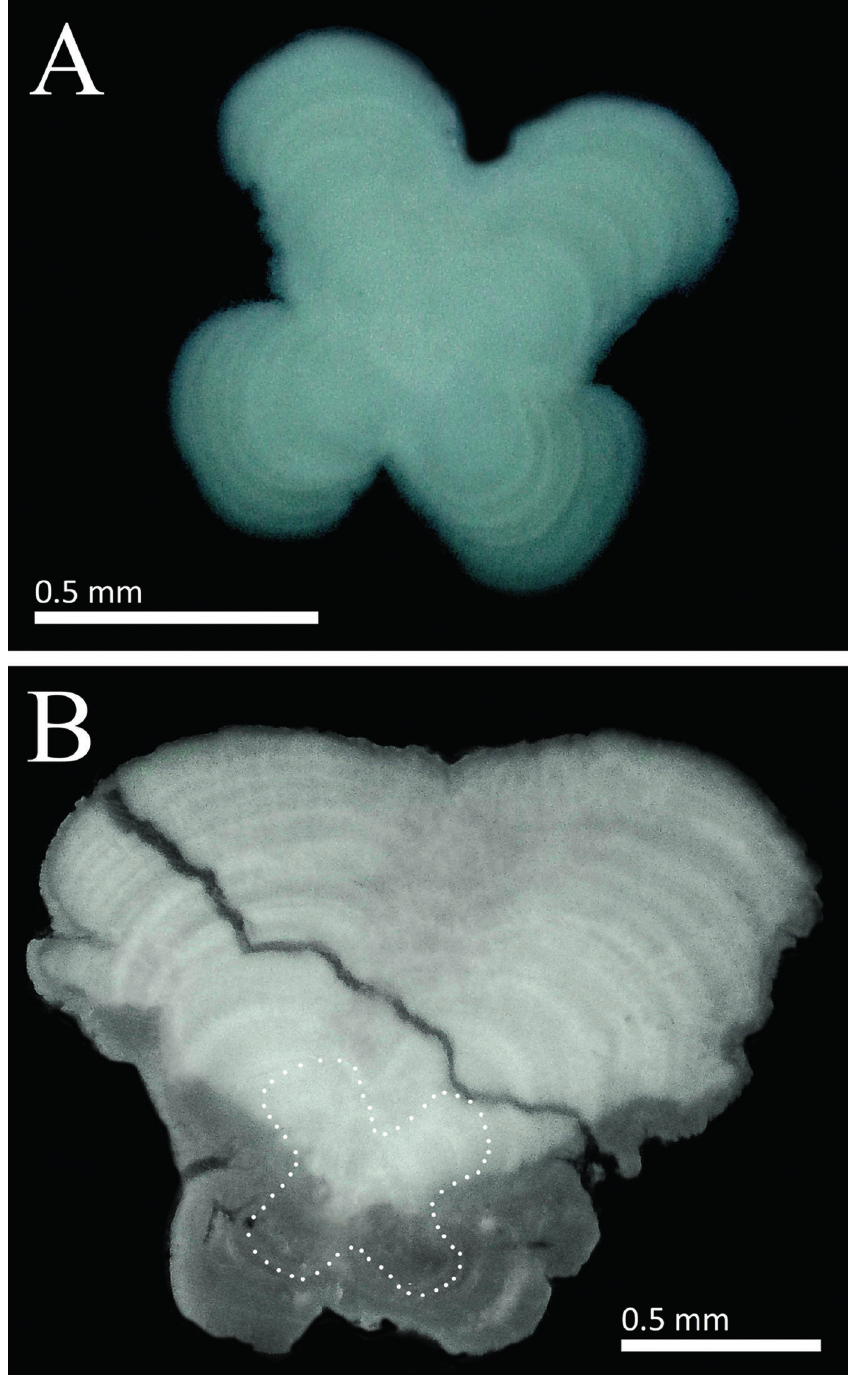
Fig. 5. Gyrophyllum hirondellei Studer, 1891. Cross-sections of the axis near the rachis-peduncle limit of G. hirondellei colonies from SCOTIA cruises. A . Colony BECA (OPEN-660), a colony 112 mm in total length, showing an X-shaped cross-section, with an already apparent asymmetry. If growth rings are assumed to be produced annually this specimen is ~5 years old. B . Colony BECA (OPEN-661), a colony 215 mm in total length, showing a highly asymmetric X-shaped cross-section and a symmetrical central core (white dots). This specimen is ~14 years old according to growth rings with the proviso